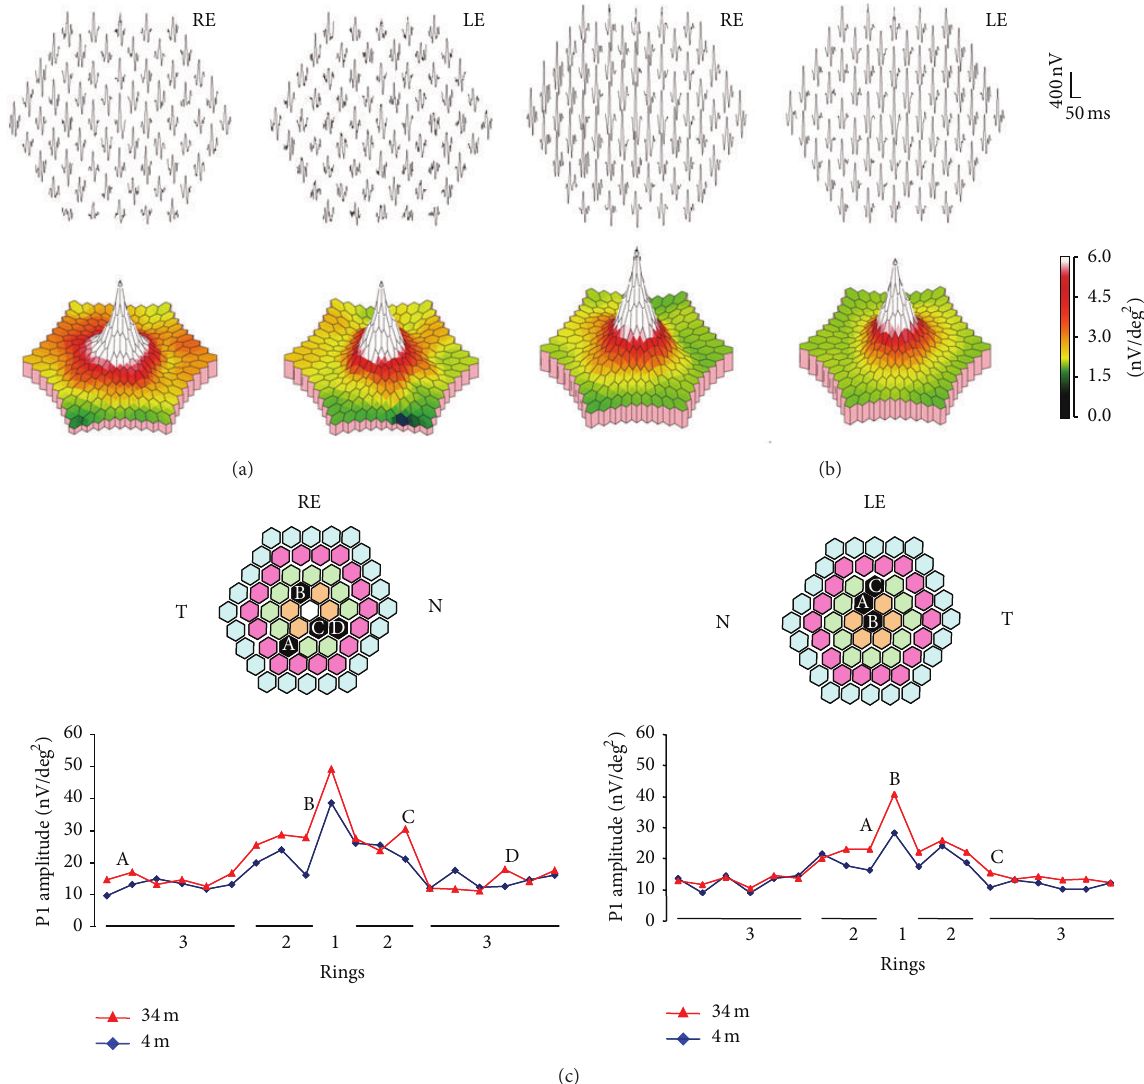
Figure 2: Trace array of 61 individual mfERG responses and three-dimensional topography response density plot (below) performed at 4 months and (b) 34 months after hydroxychloroquine dose reduction. The follow-up with mfERG showed a generalized increase in response amplitudes, particularly of the central ring. (c) P1 amplitudes of the responses obtained in rings 1–3 in the first (shown in (a), red line) and last (shown in (b), blue line) mfERG performed. Hexagons with increments higher than 40% in the follow-up are marked (A–D). LE: left eye; m: months; N: nasal; RE: right eye; T: